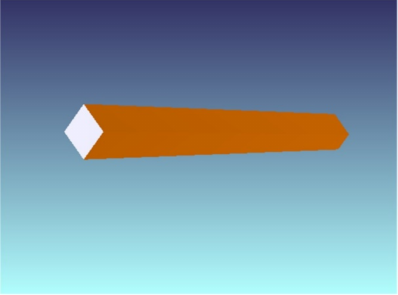
Figure 18. Shaded model layout of the homogenizing pipe.